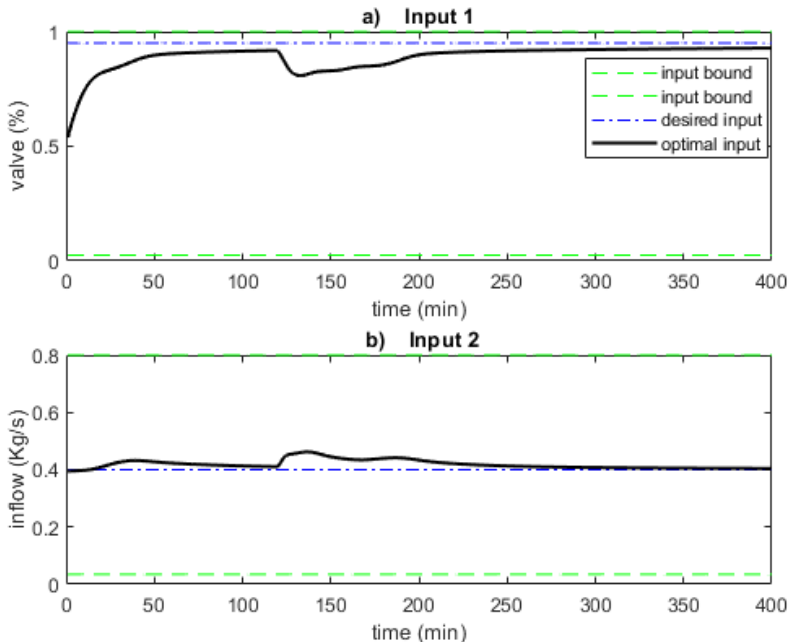
Figure 13. Two inputs of the gas-lifted system. The second optimal input follows the desired input u des = 0.4 kg/s as close as